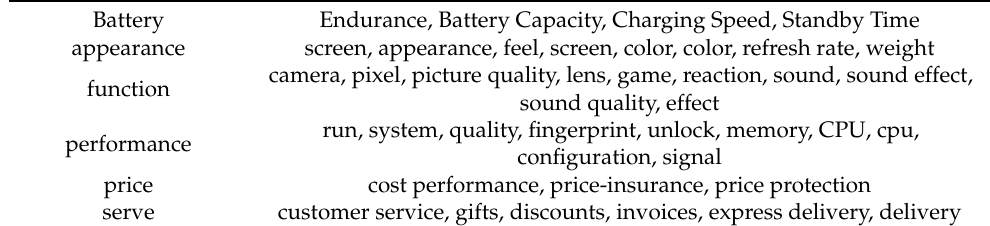
Table 2. Evaluation Feature Vocabulary.